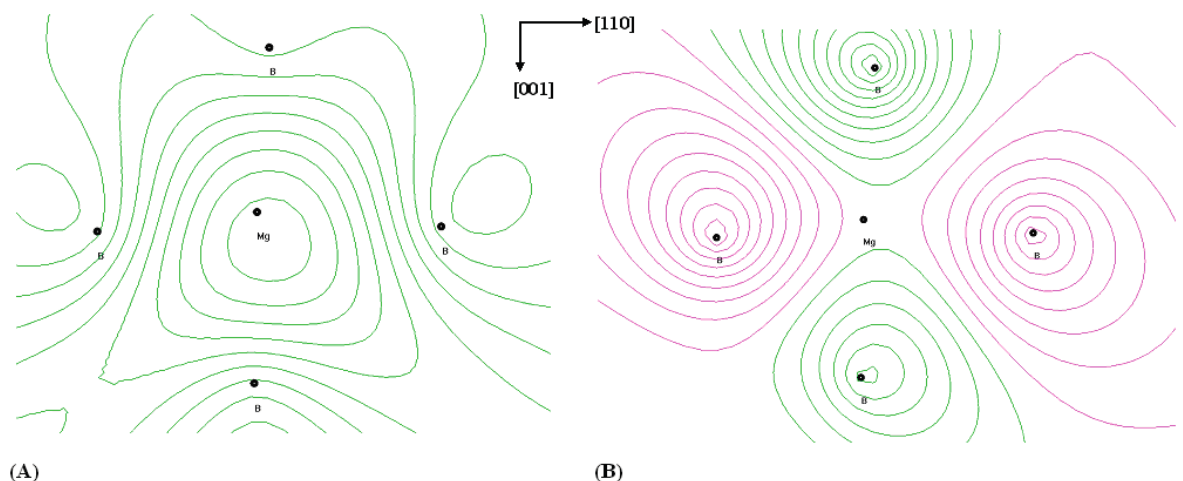
Figure 5. Charge density distribution for principal clusters of Mg-B 6 for pure MgB 2 films ( A ) and differential charge density for the Cr doped with respect to pure MgB 2 films ( B ). Increment is equal to 0.2 e/ Ω